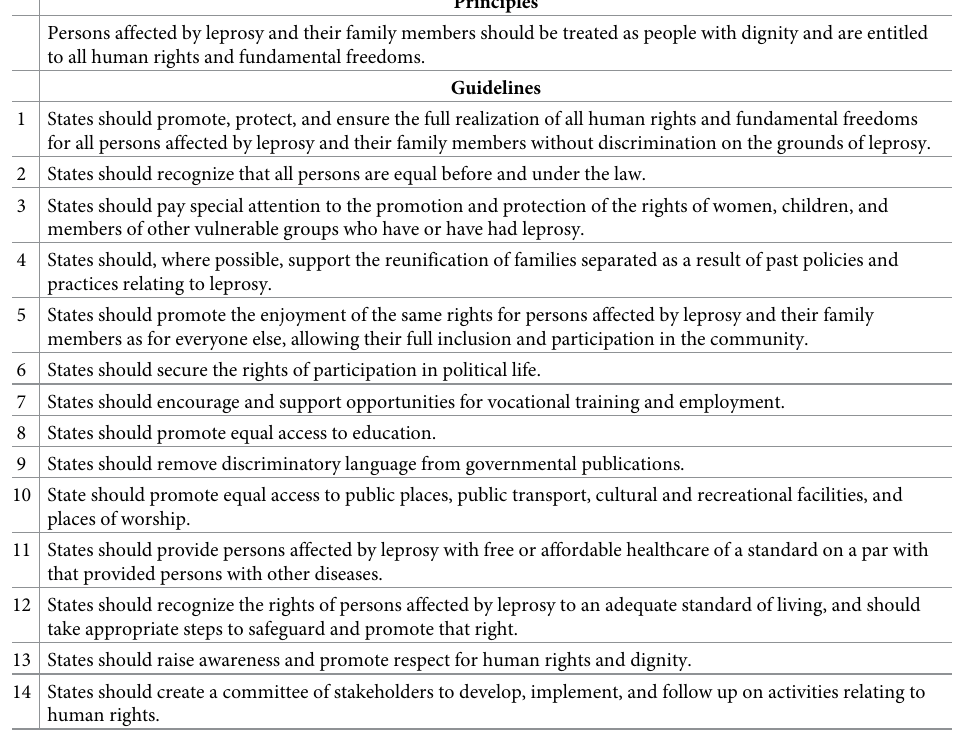
Table 2. Gist of the principles and